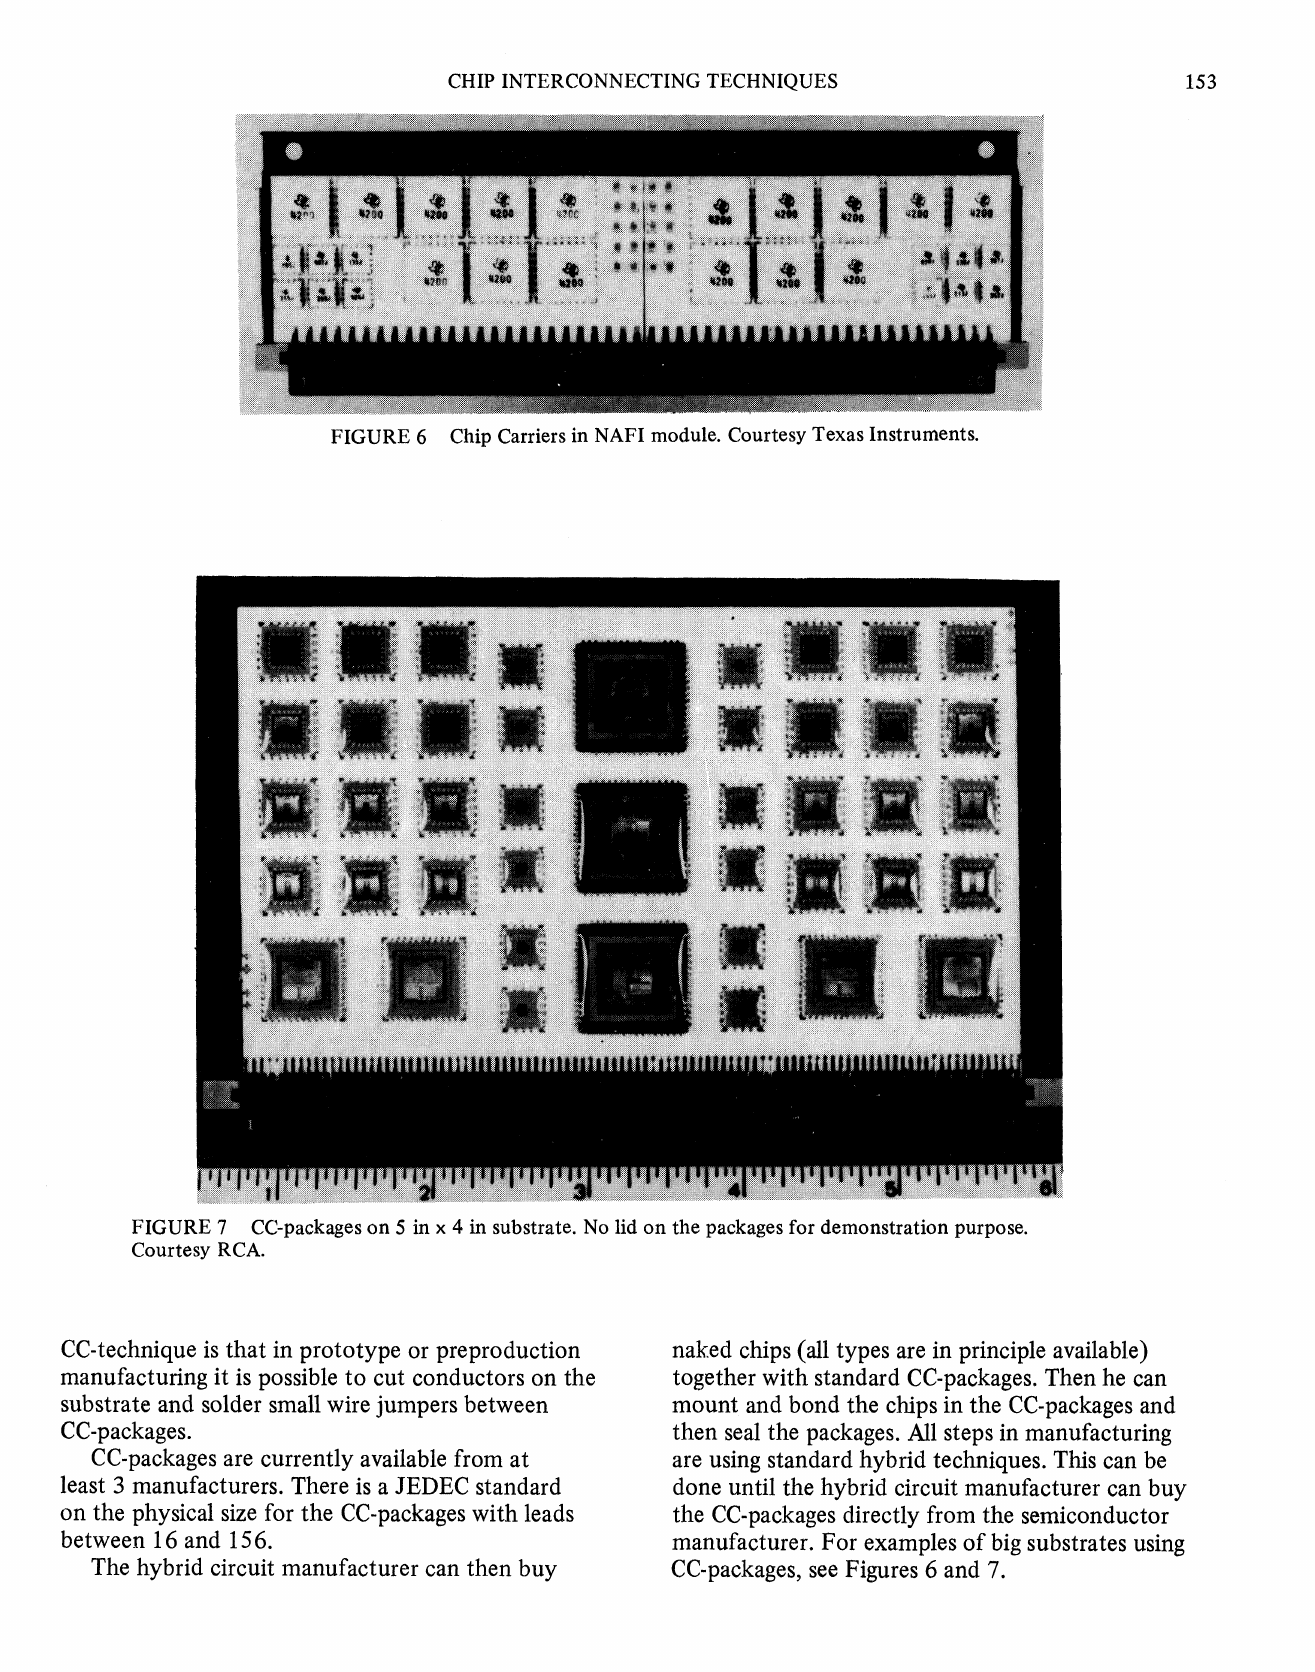
CC-packages on 5 in x 4 in substrate. No lid on the packages for demonstration purpose. Courtesy